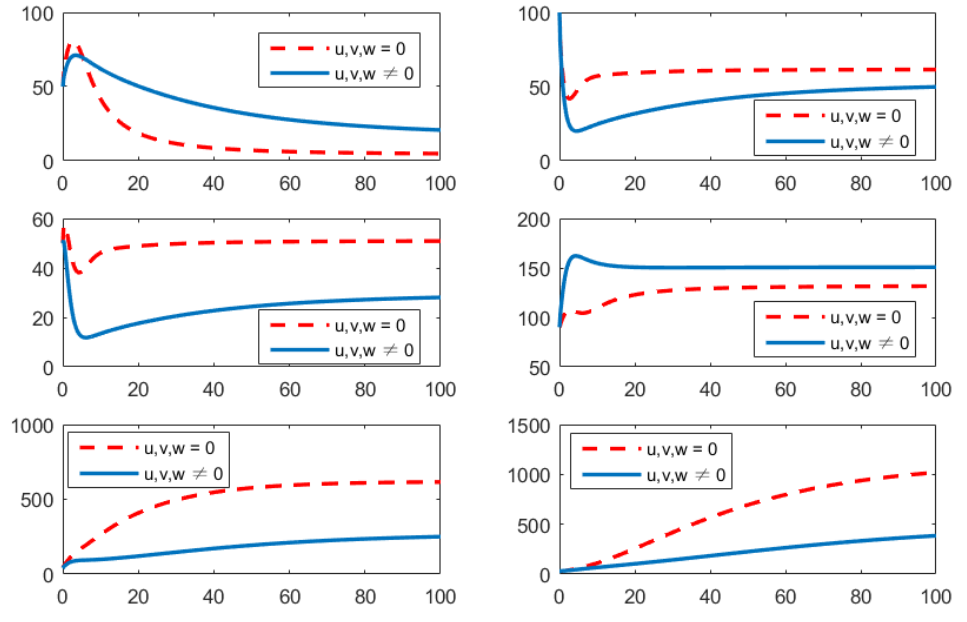
Figure 5. Comparison of adopting strategy A 3 versus not adopting. From left to right is S , E , I , R , V I , V E , respectively. The x -axis and y -axis, respectively, represent the time (days) and the corresponding population